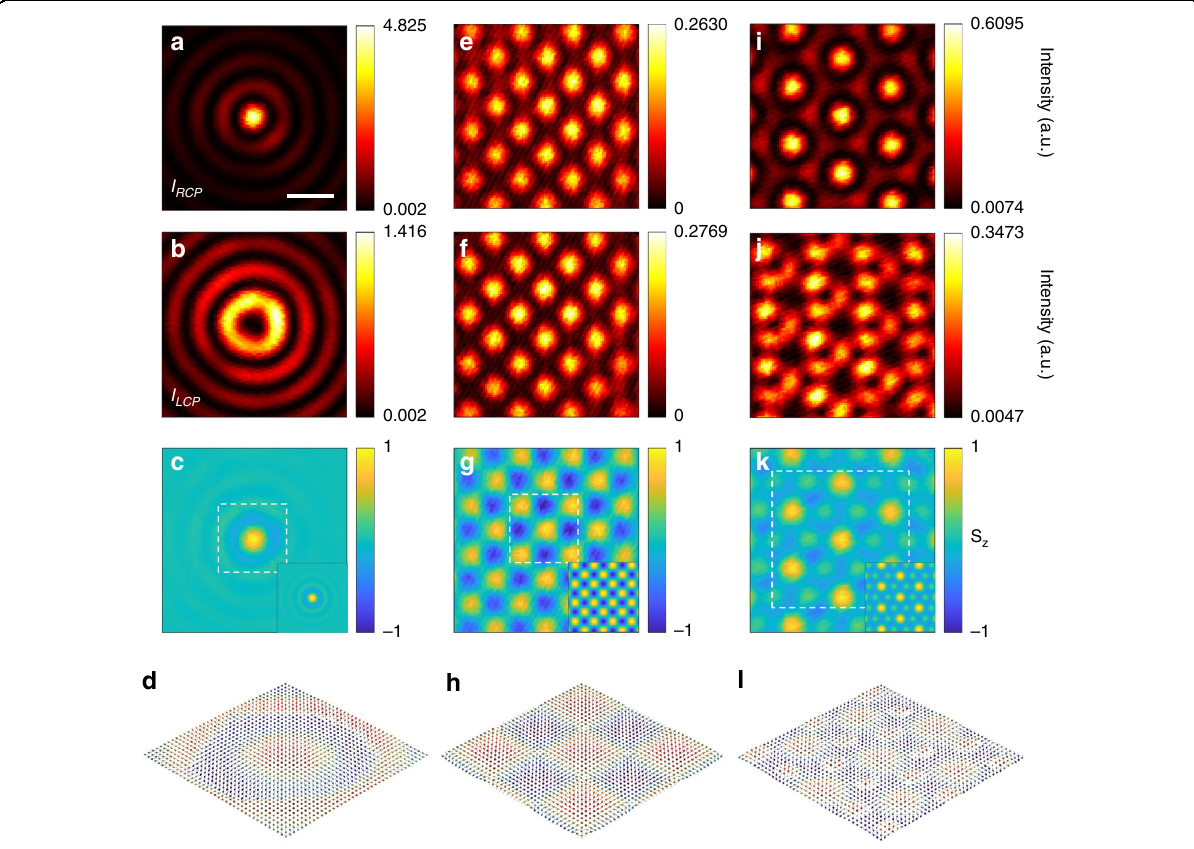
Fig. 5 Measurement of the various photonic spin topological structures of the TE mode dominated by magnetic fi elds. a – d individual spin- Skyrmion, e – h spin-Meron lattice, i – l spin-Skyrmion lattice. From top to bottom are: the RCP components of the in-plane magnetic fi elds ( I RCP ), the LCP component ( I LCP ), the normalized z -component SAM ( S z ), and the reconstructed spin vector patterns. Insets in c , g and k are calculated S z distributions for comparison. The scalar bar in a is 0.5 μ m and all of contour maps have the same area. Regions of d , h and l correspond to the white dashed boxes in c , g and k ,